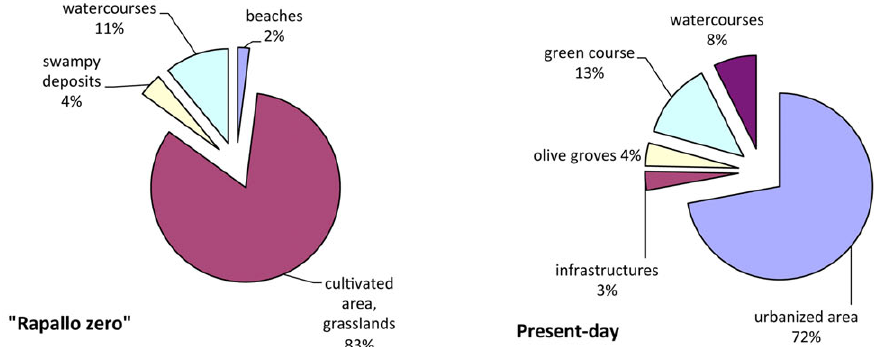
Fig. 13. Pie charts of land use of the floodplain at “Rapallo zero” and present-day